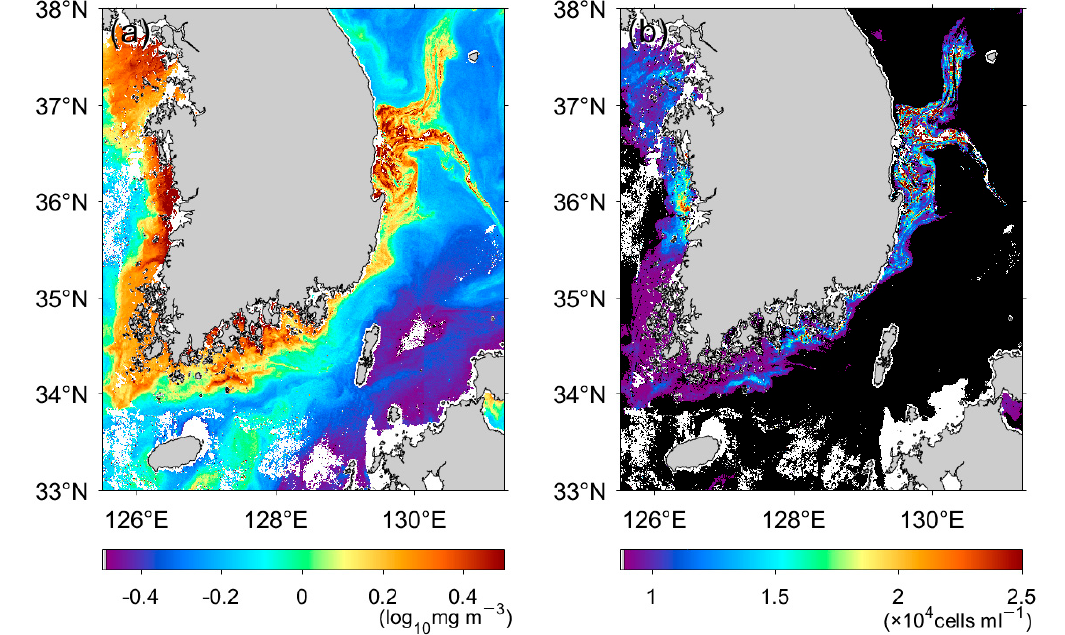
Figure 11. ( a ) Chlorophyll- a concentration (log 10 mgm − 3 , OC3 algorithm), ( b ) estimated red tide density using NRTI (04 UTC, 13 August 2013).